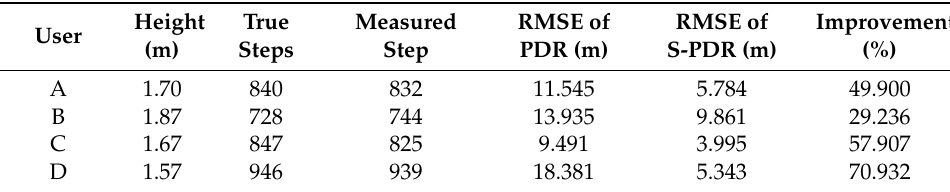
Table 11. Accuracy analysis of trajectories using the iPhone.